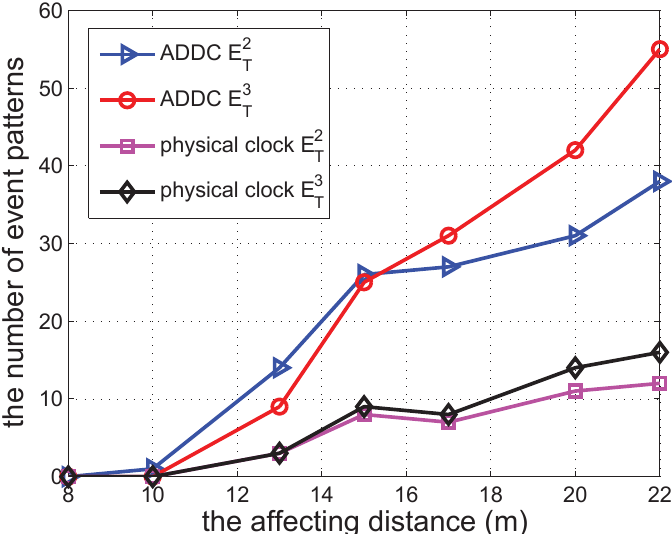
Figure 8. The number of event patterns vs. affecting